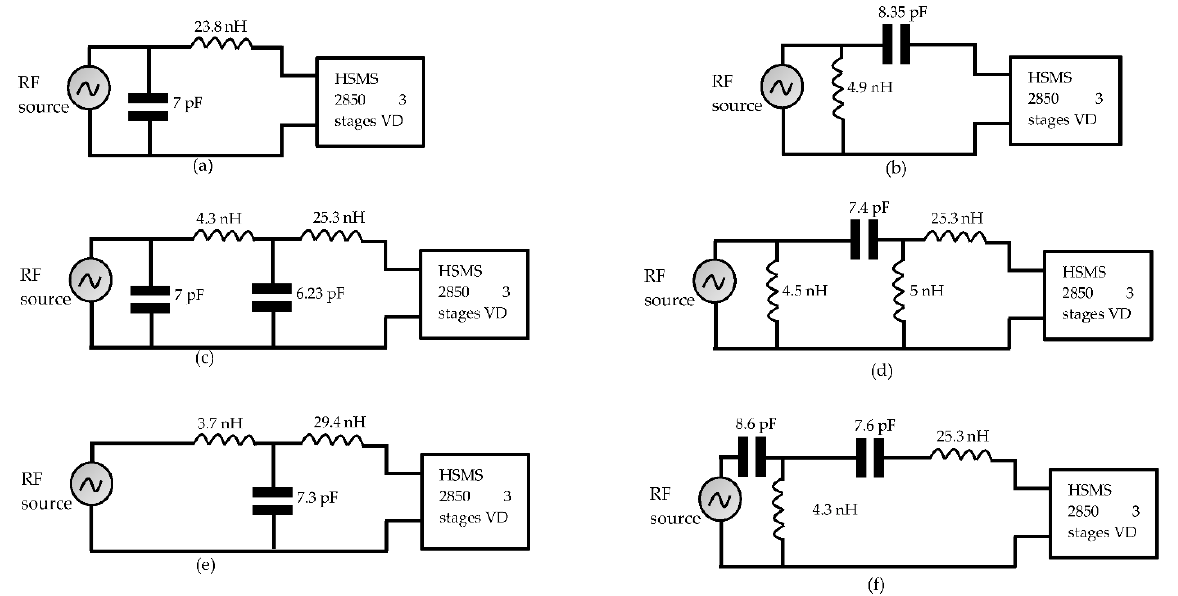
Figure 16. Designed matching filters for 3-stages voltage multiplier. ( a ) L low pass. ( b ) L high pass. ( c ) π low pass. ( d ) π high pass. ( e ) Tee low pass. ( f ) Tee high pass.